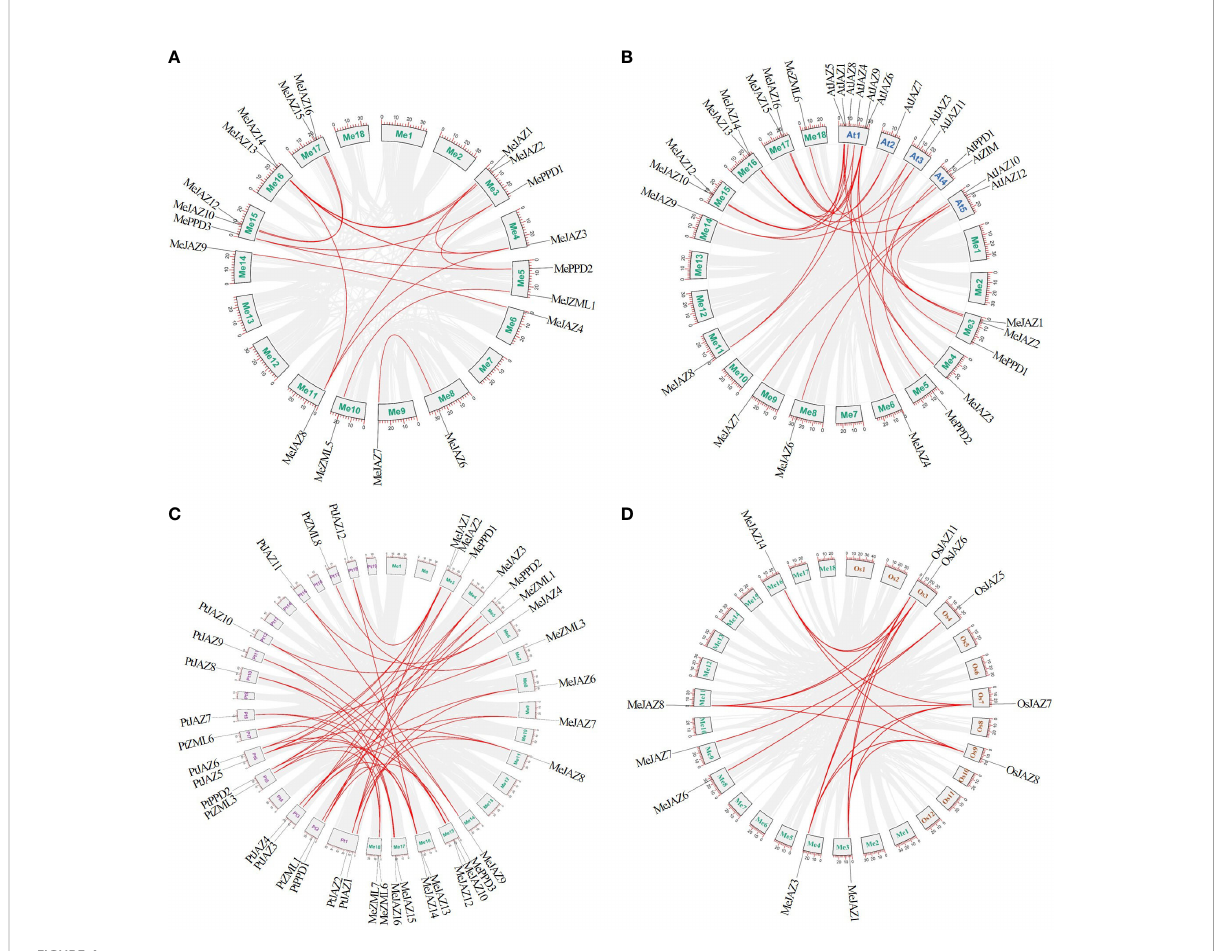
FIGURE 4 Synteny analysis of ZML , PPD and JAZ genes. (A) Orthologous relationships between cassava and its genome ancestors. (B) The syntenic ZML , PPD and JAZ genes between cassava and Arabidopsis . (C) The syntenic ZML , PPD and JAZ genes between cassava and Populus trichocarpa . (D) The syntenic ZML , PPD and JAZ genes between cassava and rice. The cassava, Arabidopsis , Populus trichocarpa , and rice chromosomes are shown in different color boxes and labeled Me (green), At (blue), Pt (purple), and Os (orange), respectively. The gray line in the background indicates a collinear block in the genome of cassava and other plants, while the red line highlights the isomorphic gene